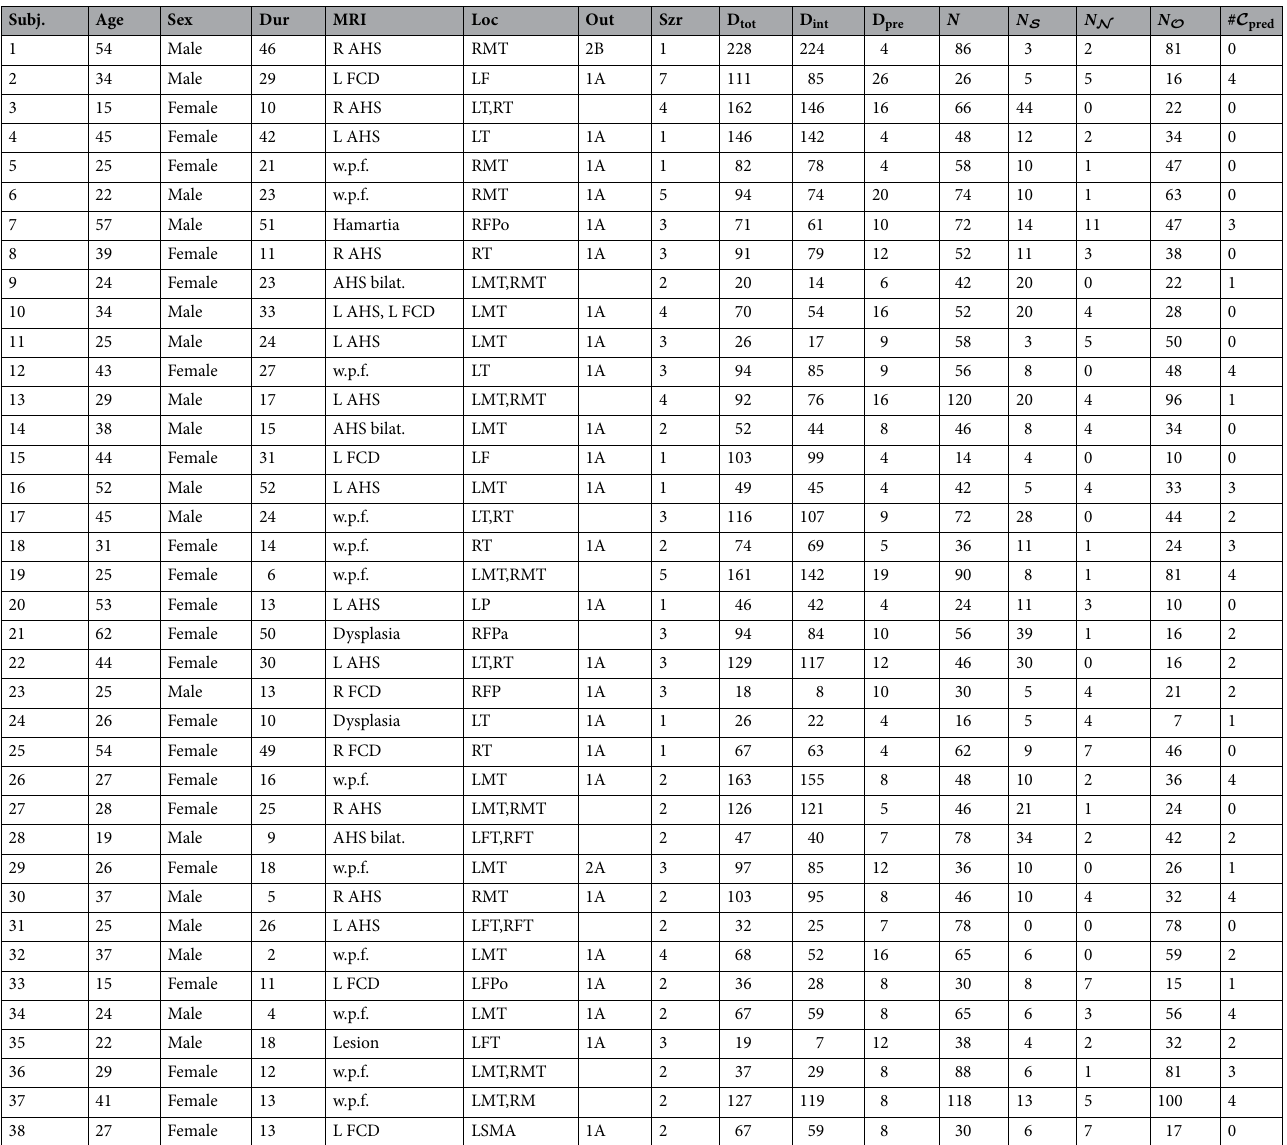
Table 1. Subject demographics. Age age at time of presurgical evaluation, Dur duration of epilepsy in years, MRI MRI findings ( w.p.f. without pathological findings, AHS Ammon’s horn sclerosis, bilat. bilateral, FCD focal cortical dysplasia), L left, R right, Loc location of seizure onset zone ( MT mesial temporal, SMA supplementary motor area, P parietal, F frontal, Fpo frontopolar, Fpa frontoparietal, FT frontotemporal,